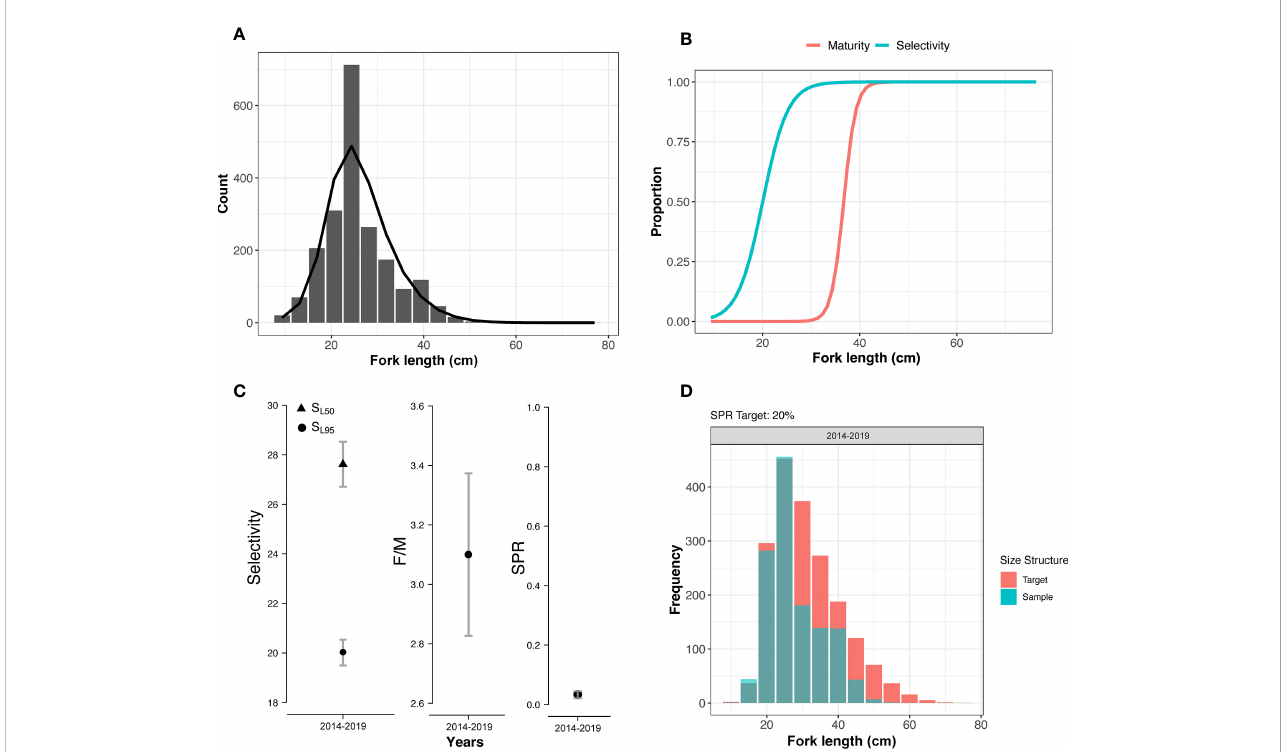
FIGURE 5 LB-SPR model outputs for South China Sea skipjack tuna. (A) length-frequency distribution (pillars), and predicted fi shed size composition (black line); (B) maturity and selectivity curves from the fi tted LBSPR model when L 50 = 36.7 cm and L 95 = 40.4 cm; (C) shows the distribution of mean selectivity parameters ( SL 50 and SL 95 ), fi shing mortality to natural mortality ( F / M ), and spawning potential ratio; (D) observed length-frequency data against an expected size composition at a target SPR =